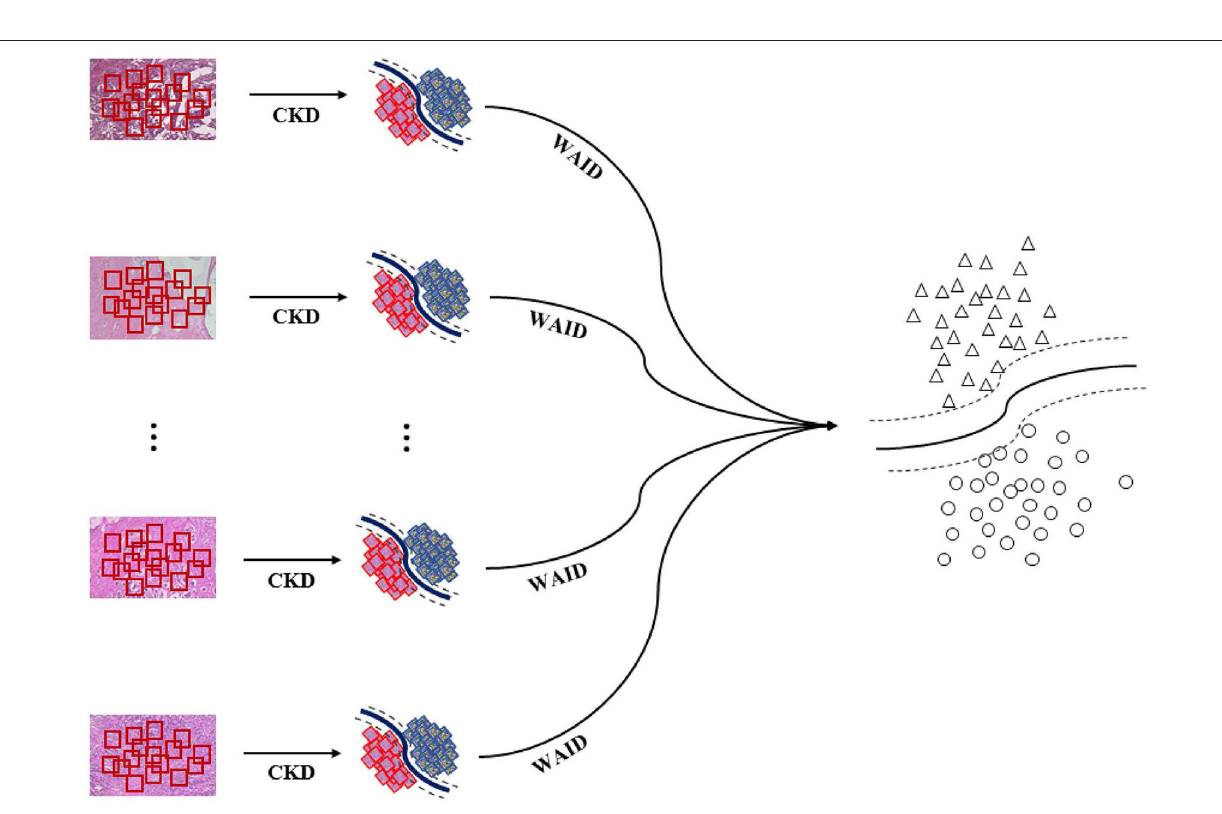
Frontiers in Digital Health |